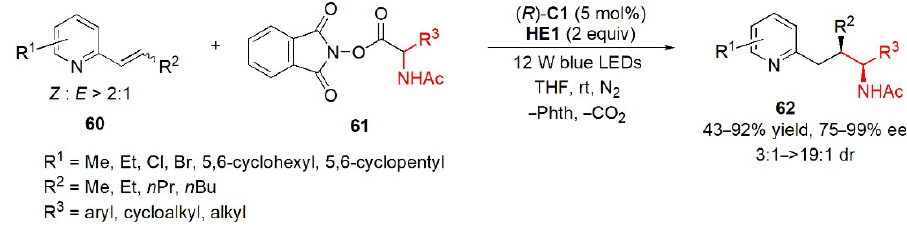
Figure 22. Enantioselective hydroalkylation of internal alkenylpyridines [93]. The redox-active esters 61 were prepared from natural and unnatural amino